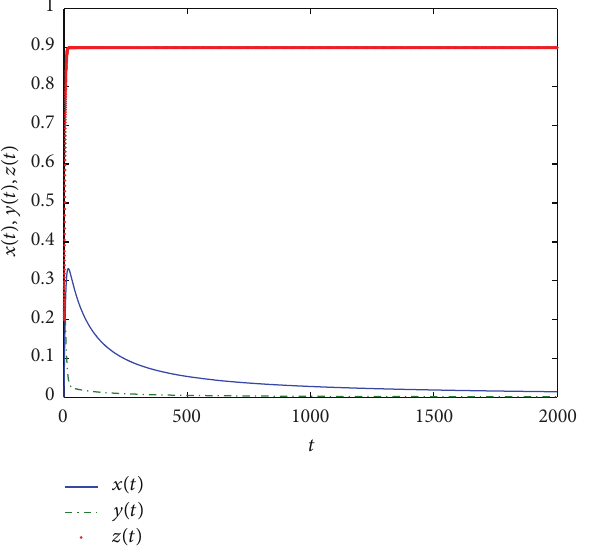
Figure 6: Parameters: 𝛽 = 0.2, 𝛼 = 0.14, 𝛾 = 0.02, 𝜇 = 0.05, 𝜔 = = 0.1, and 𝛿 = 0.5 0.05, 𝑐 = 0.1, 𝛿 1 2